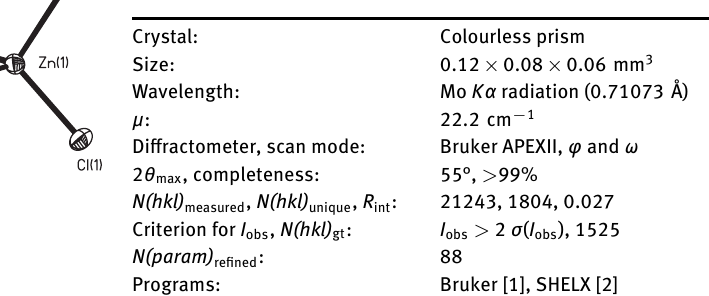
Table 1: Data collection and handling.